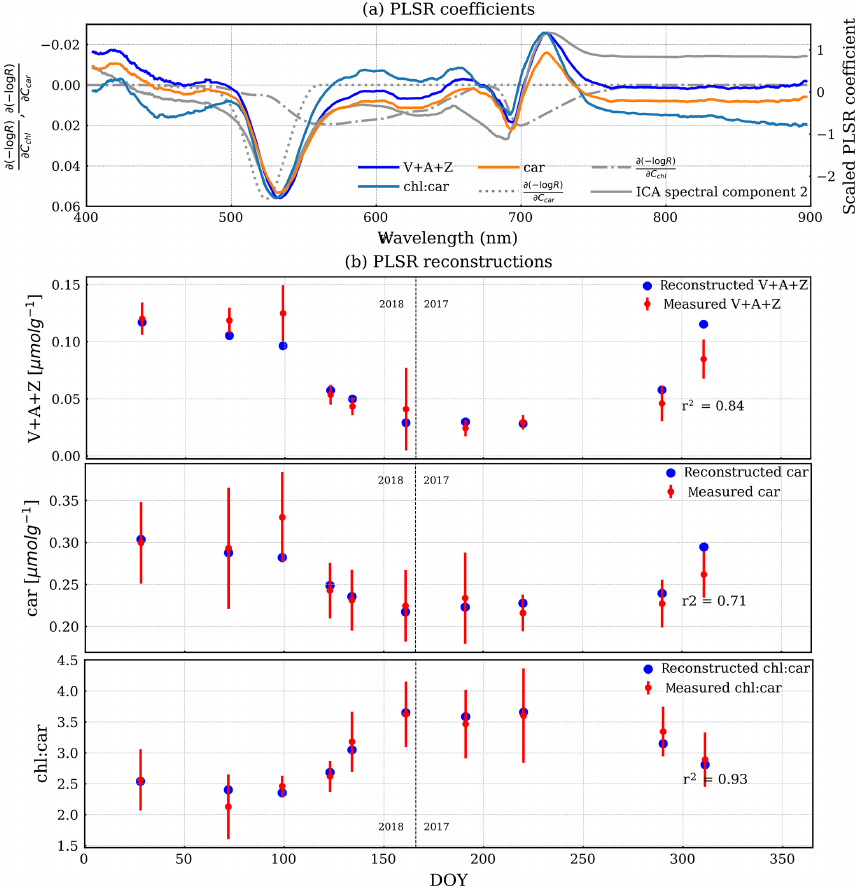
Figure 7. (a) PLSR coefficients of reflectance and three pigment measurements. The overlaid dashed–dotted and dotted lines are chlorophyll and carotenoid Jacobians, respectively. The overlaid solid grey line is the second ICA spectral component, which is scaled to fit to the plot without a y axis. (b) The reconstructed pigment measurements (blue) by PLSR are overlaid with the measured mean pigment measurements (red). The error bar is 1 standard deviation of the measurements. The vertical dashed line divides the observations from DOY for the years 2017 and